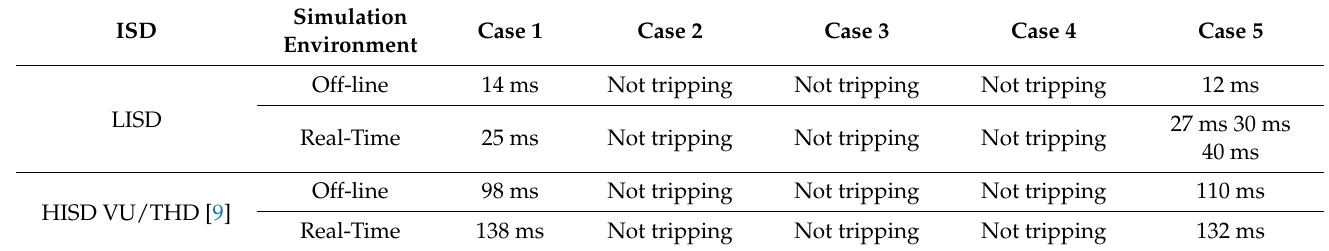
Table 3. Performance comparison of Islanding detection